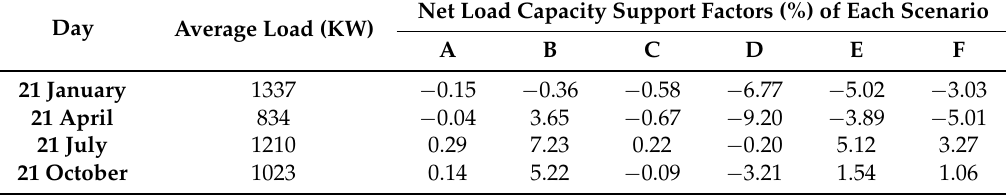
Table 2. Net load capacity support factors for 6 selected scenarios and 4 selected days.